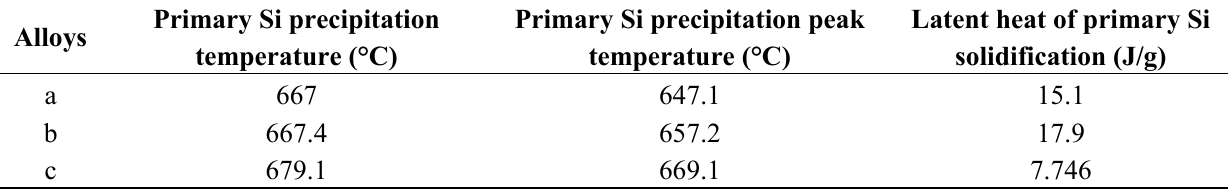
Table 1. Some crystallization parameters of primary Si by DSC